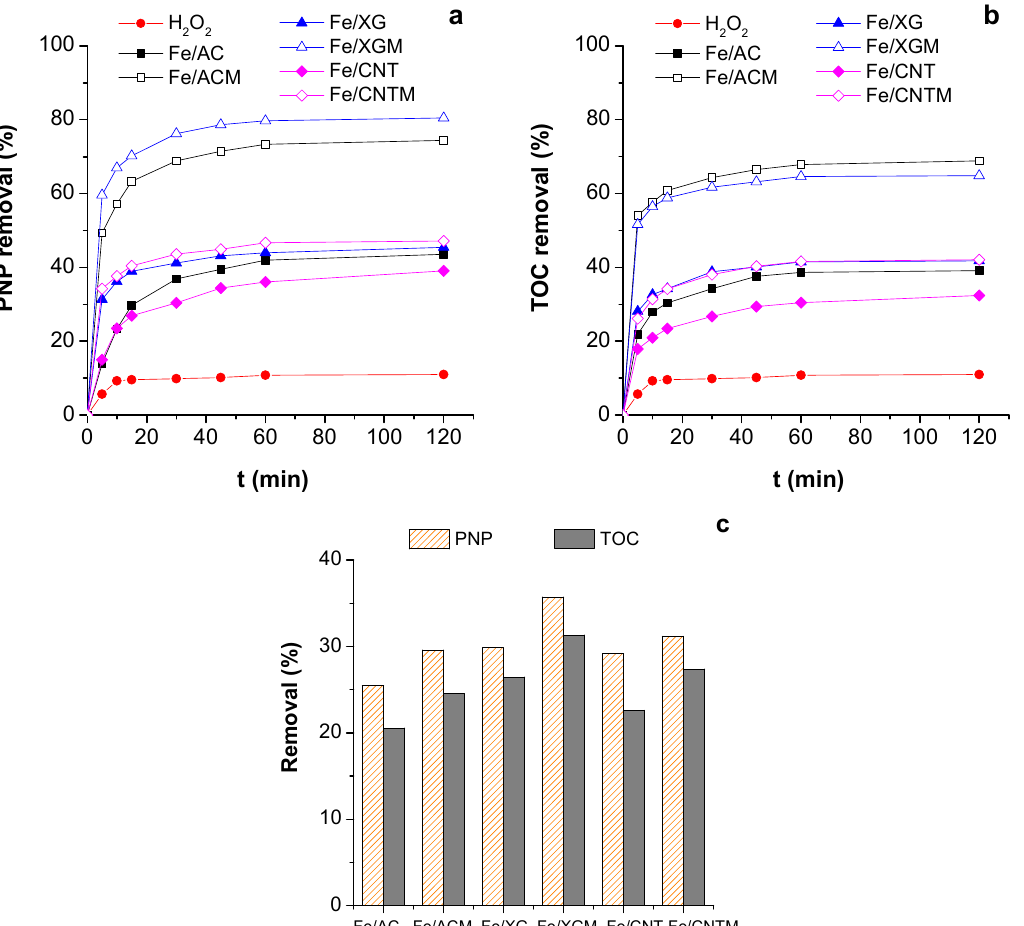
Figure 4. p -nitrophenol (PNP) ( a ) and total organic (TOC) ( b ) removal during Fenton’s reaction and adsorption, and PNP and TOC removal, after 2 h, for Fenton reaction only ( c ) with the Fe-containing catalysts (pH = 3.0, T = 30 °C, [catalyst] = 0.25 g L −1 , [H 2 O 2 ] = 29 mmol L −1 , [PNP] = 3.6 mmol L −1 and H 2 O 2 :PNP molar ratio = 8.1).